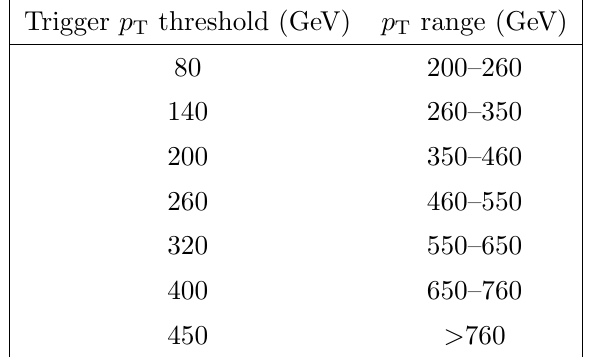
Figure 2 . JMR in simulation (width of a (cid:12)t to m reco =m gen ) for ungroomed (left) and groomed (right) jets in di(cid:11)erent generated p T bins, as a function of the generated mass, with our selection. The correction to match the data is 1 : 07 (cid:6) 0 : 12. Uncertainties are not shown, for clarity, although statistical (cid:13)uctuations at high masses near the splitting threshold for each p T bin are not negligible.